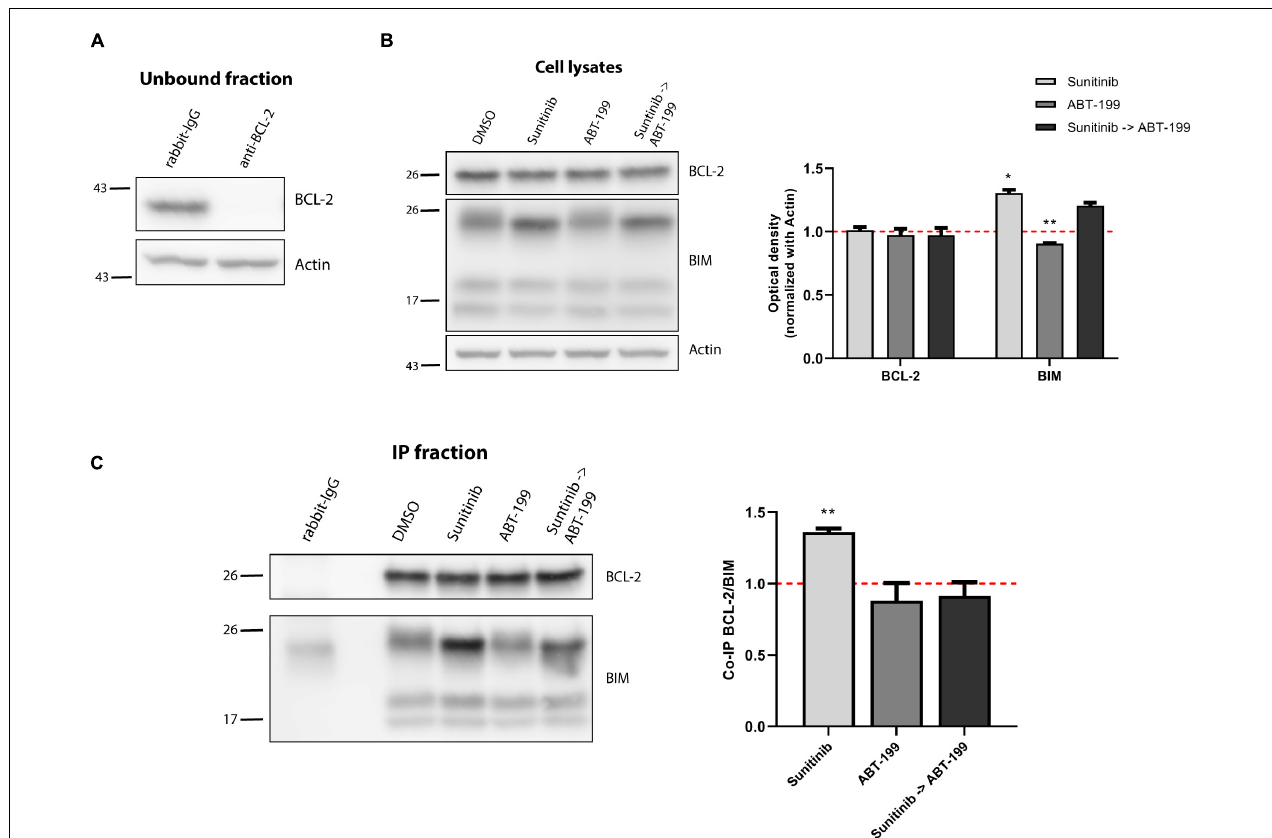
FIGURE 6 | BCL-2 binds to BIM after sunitinib treatment promoting synergy with ABT-199. (A) Western blot analysis of the unbound fraction after BCL-2 immunoprecipitation. (B) Immunodetection of BCL-2 and BIM initial expression in cell lysates after 16 h of incubation with sunitinib 100 nM, and 4 h incubation with ABT-199 10 nM. Quantification of optical density for each protein was normalized to actin and fold-change was calculated comparing to protein expression in the control condition. (C) Western blot of the immunoprecipitated fraction to study the interaction between BCL-2 and BIM after sunitinib 100 nM treatment, and 4 h with ABT-199 10 nM. To quantify this binding, BIM optical density was normalized to BCL-2 optical density and fold-change was calculated comparing to protein expression in the control condition. All results are expressed as the mean ± SEM of at least three biologically independent replicates. Statistical significance was calculated using Student’s t -test compared to control condition and considering * p < 0.05 and ** p <